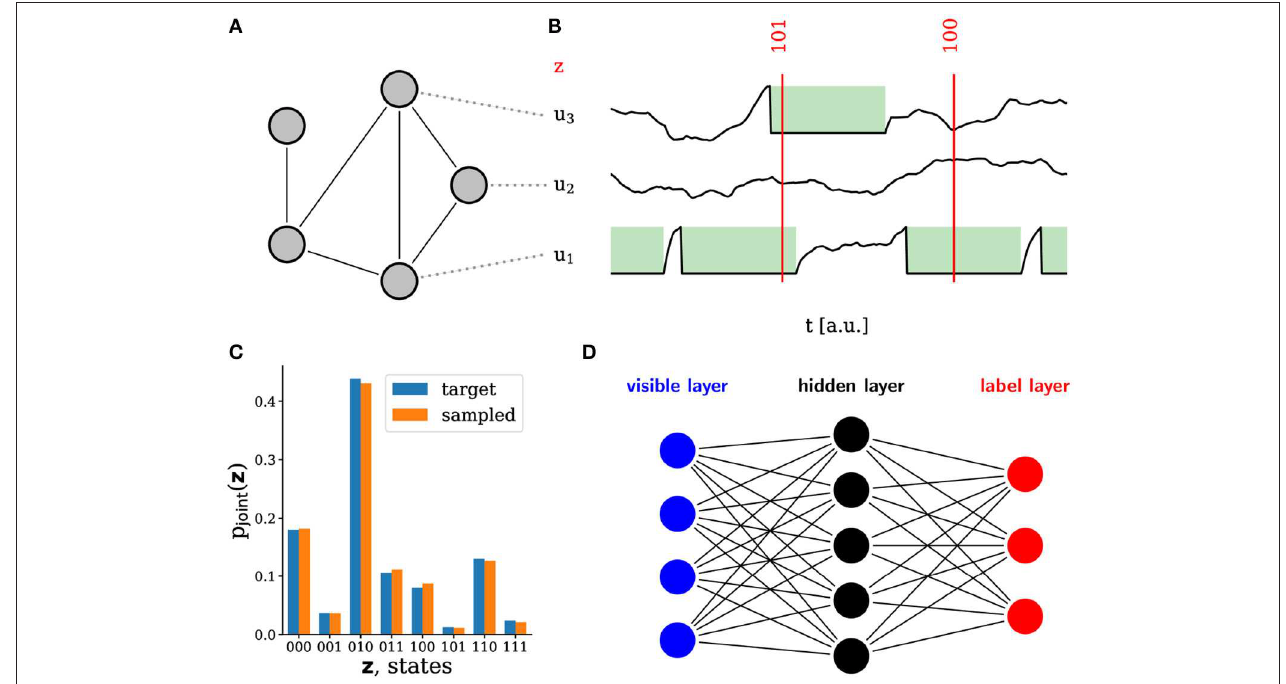
FIGURE 2 | Sampling with leaky integrate-and-fire (LIF) neurons. (A) Schematic of a spiking sampling network (SSN) with 5 neurons. Each line represents two reciprocal synaptic connections with equal weights. (B) Example membrane potentials of three neurons in the network. Following a spike, the refractory mechanism effectively clamps the membrane potential to the reset value for a duration τ ref . During this time, the RV corresponding to that neuron is in the state z = 1 (marked in green). At any point in time, the state sampled by the network can therefore be constructed directly from its output spikes and the refractory time τ ref of the neurons. (C) Probability distribution sampled by an SSN with three neurons as compared to the target distribution. (D) Based on this framework ( Petrovici et al., 2016), hierarchical sampling networks can be built, which can be trained on real-world data. Each line represents a reciprocal connection (two synapses) between the connected